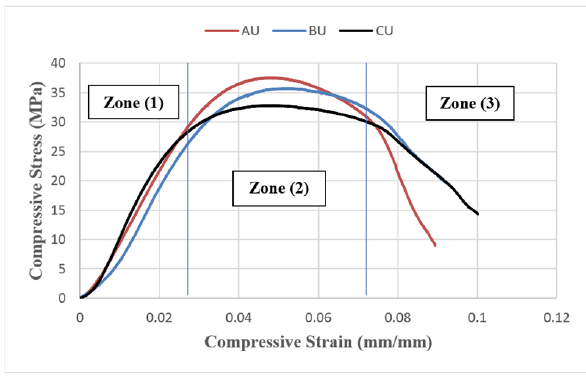
Figure 3: Graph of stress versus strain of unconfined polymer con- crete